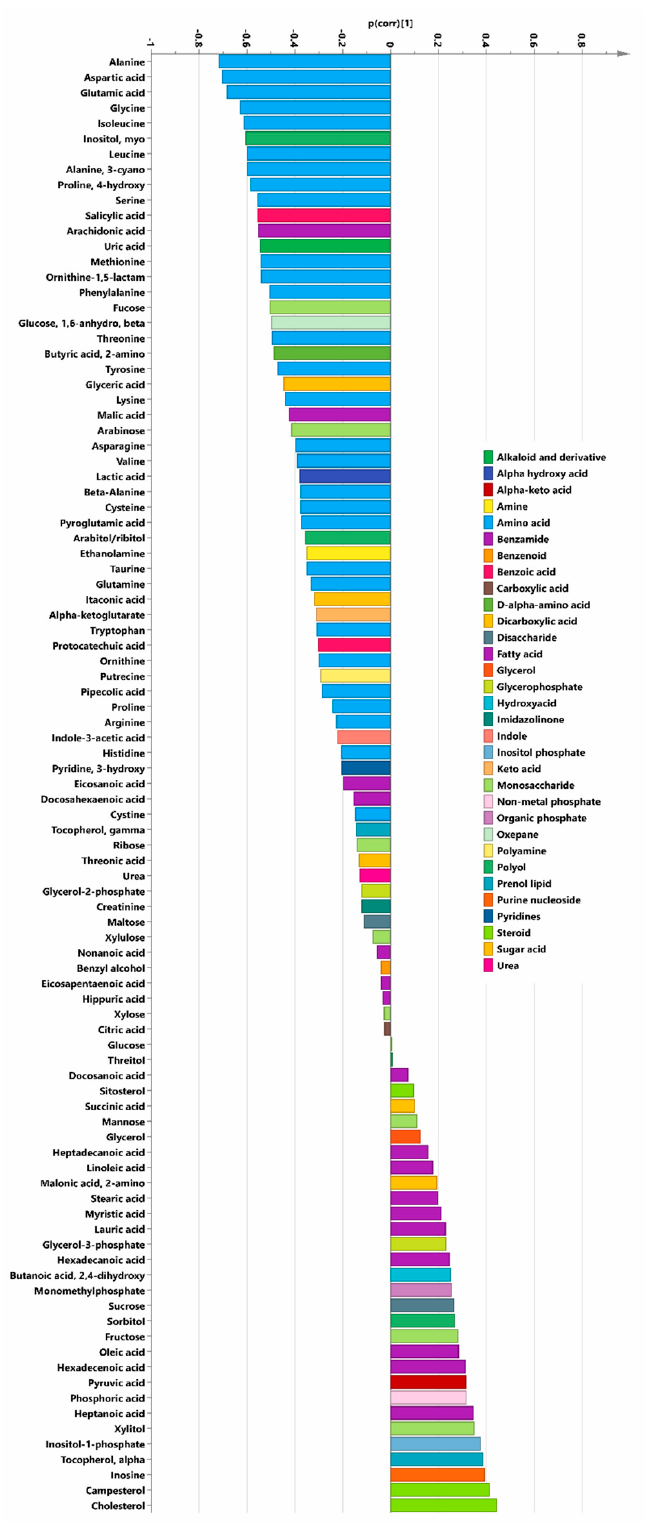
Figure 3. P(corr) loading vector from the OPLS-DA model with the 95 metabolites identified in plasma of men ( n = 9) receiving a daily addition of SeQ 10 for 18 months as compared with placebo-treated men (controls; n = 8). Note: Bars pointing to the left from mean (0) indicate metabolites with lower levels in SeQ 10 -treated men. Amino acids are marked in light blue.